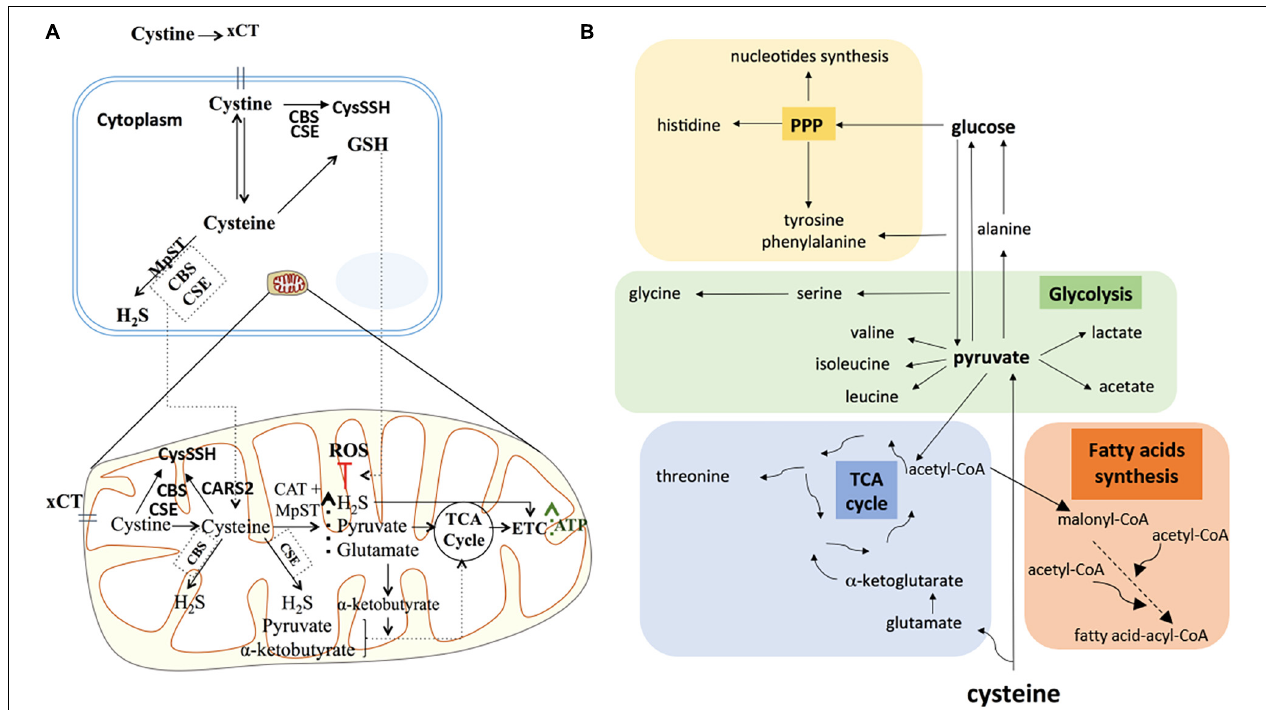
FIGURE 7 | Cysteine possible direct and indirect roles in ATP synthesis and in carbon metabolism reprogramming under hypoxia in ovarian cancer cells. (A) Under hypoxia, cysteine degradation could contribute directly to ATP production via not only H 2 S generation, but also via pyruvate and α -ketobutyrate that could further supply the TCA cycle, leading to increased ATP synthesis. Cysteine could also present an indirect role in ATP synthesis mediated by increasing GSH content under hypoxia, hence counteracting oxidative stress and thereby increasing cellular metabolism. Cystine can also be converted into cysteine persulfide (CysSSH) by CSE and CBS in the cytoplasm or by CSE, CBS and CARS2 in the mitochondria. (B) The axis cysteine-pyruvate-glucose is central in whole metabolic network of carbon. Cysteine degradation can originate pyruvate and glutamate. Pyruvate besides being a major supplier of tricarboxylic acids (TCA) cycle, it can be converted into valine, isoleucine, leucine, alanine, lactate, and acetate. Alanine can be a source of glucose through gluconeogenesis. Glycolysis produce intermediates to supply the TCA cycle (a hub for many precursors of organic compounds, such as threonine) and the pentose phosphate pathway (PPP). PPP intermediates can be converted into amino acids such as histidine and can be conjugated with glycolysis intermediates, originating tyrosine, phenylalanine and serine, which can be converted into glycine. PPP is also crucial in the nucleotide’s synthesis. Acetyl-CoA is a central organic compound in metabolism, when cysteine-derived it proves that cysteine is a valuable supplier of TCA cycle and amino acids and fatty acids syntheses. The increased concentration of these compounds under hypoxia, suggests that cysteine is pushing the metabolic flow in order to supply the main carbon metabolic pathways. The direct incorporation of cysteine into these compounds is possible, however, further studies are needed to clarify this. Based on information from